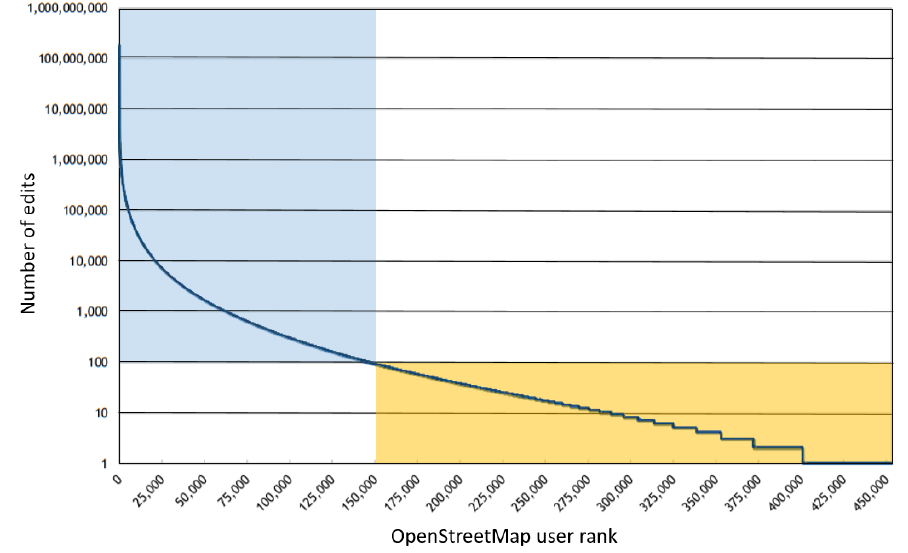
Figure 2. Participation inequality in OpenStreetMap adapted from Wood’s analysis [37]. The figure shows the number of users that contributed at least one edit. It illustrates that most of the contributions are performed by a small number of users. Only about 150,000 users (out of 2 million registered users at the time of analysis) contributed more than 100 points of data (blue side); the remaining users collectively contributed less than 100 edits (orange side).